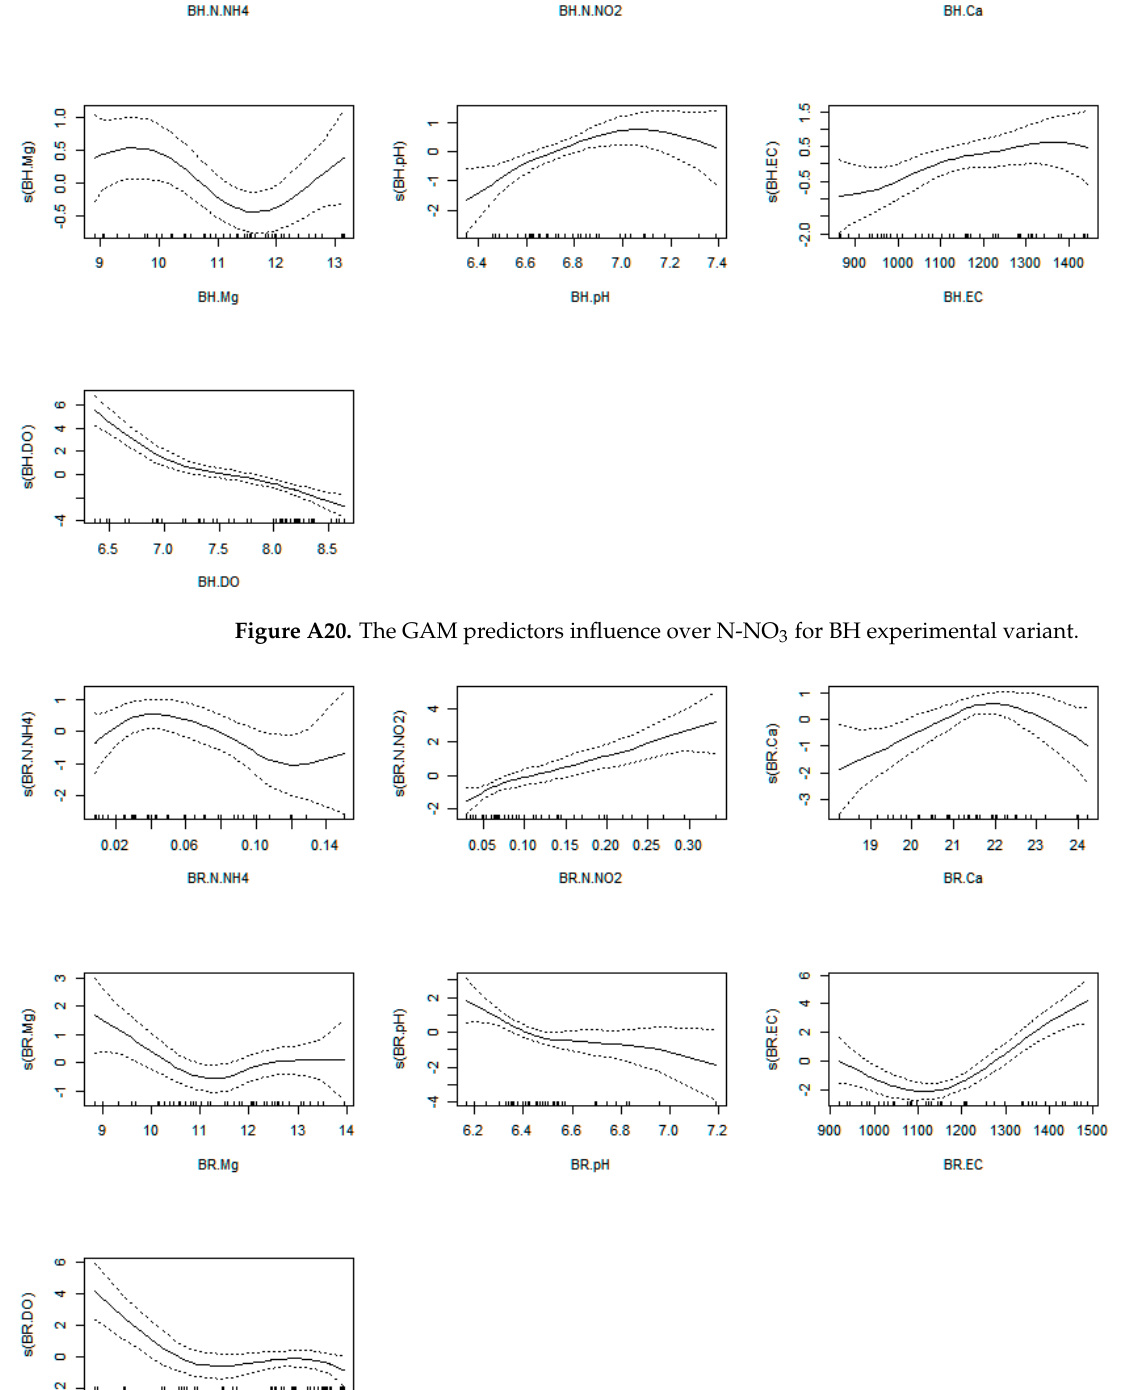
Figure A21. The GAM predictors influence over N-NO 3 for BR experimental variant.